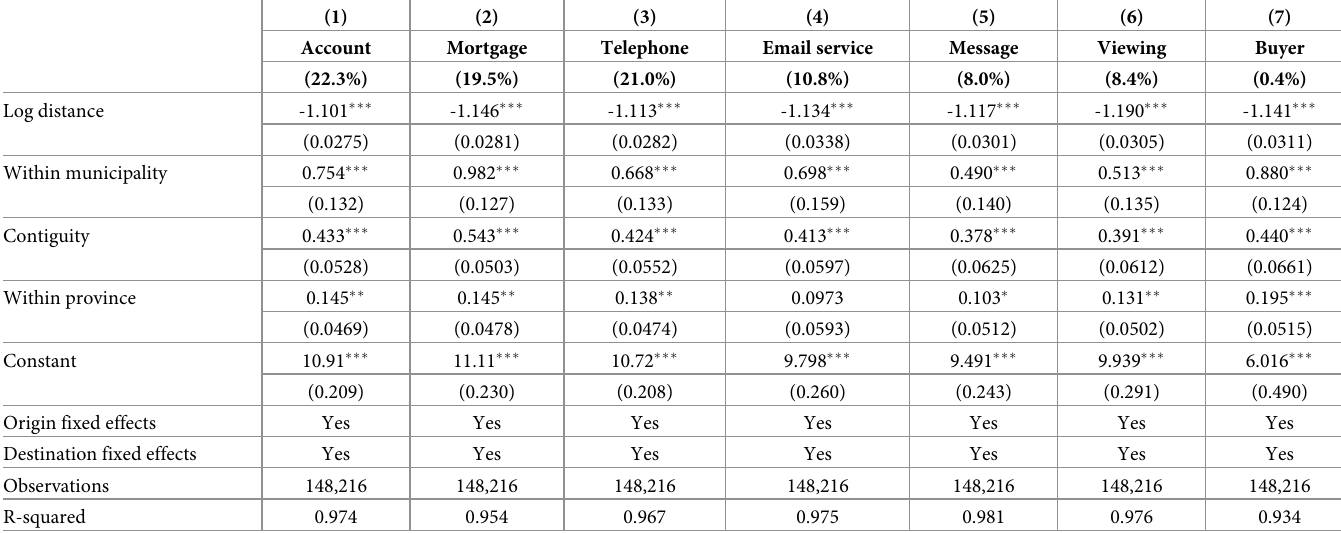
Table 5. Poisson pseudo maximum likelihood estimates for serious